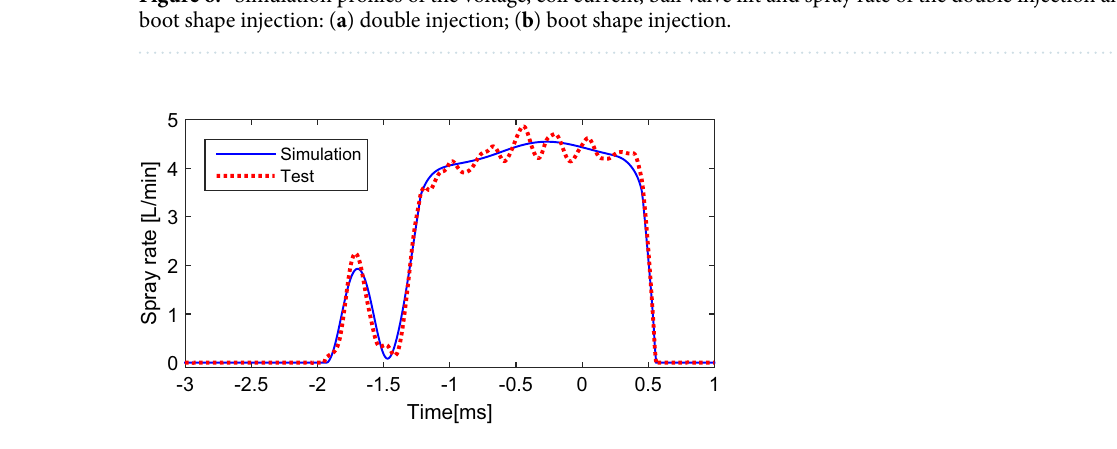
Figure 7. Injection rate profiles of test vs. that of simulation of boot shape injection under fixed